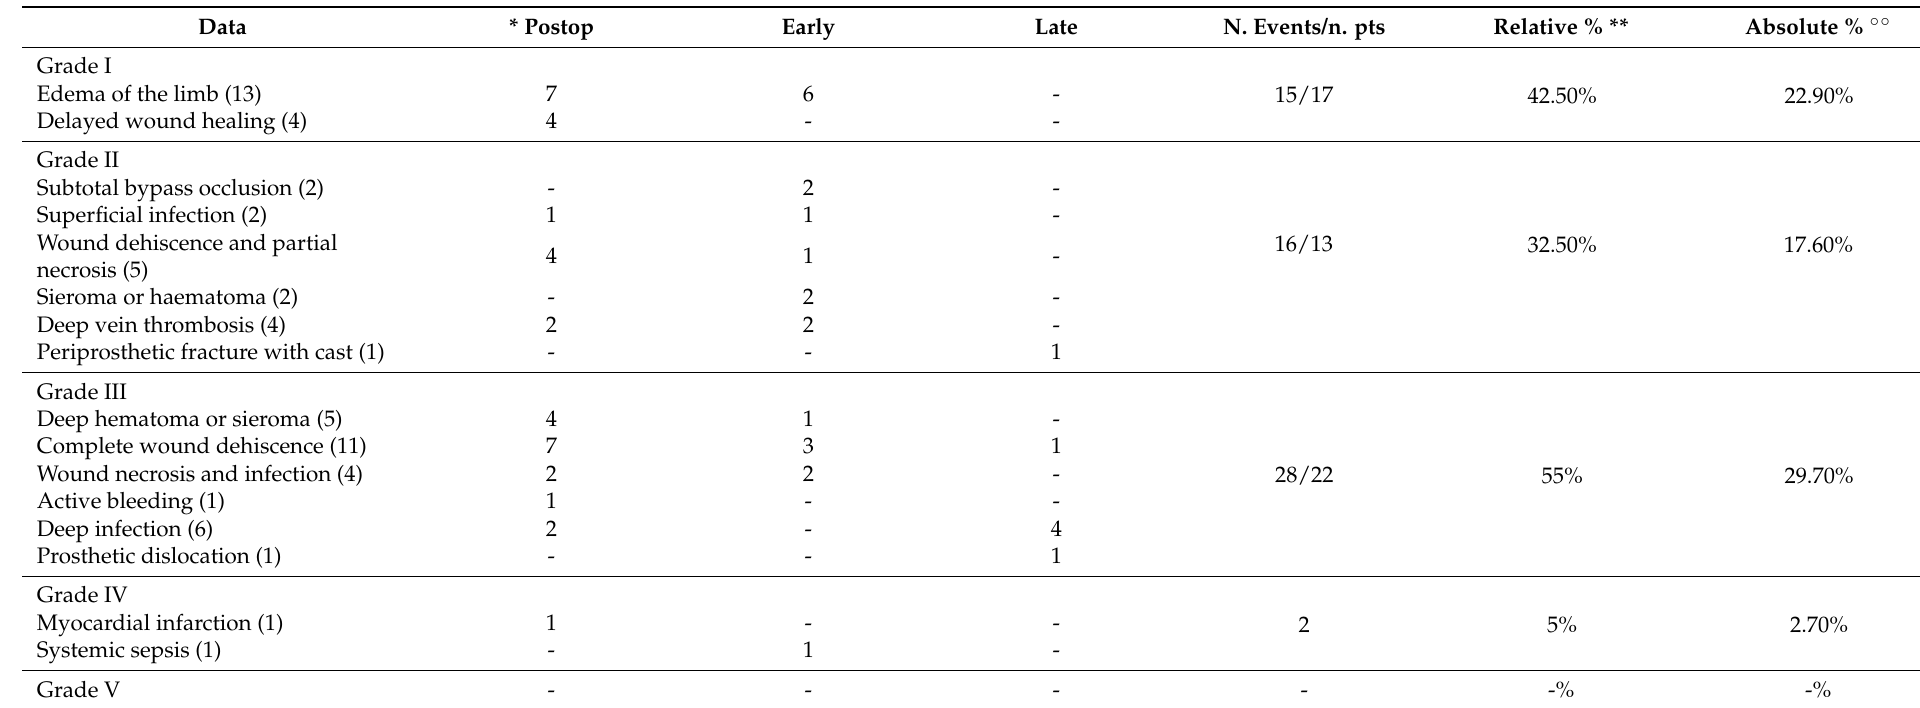
Table 2. Complications of ortho-vascular surgery in the patients included in this series, classified according to the Clavien–Dindo system.